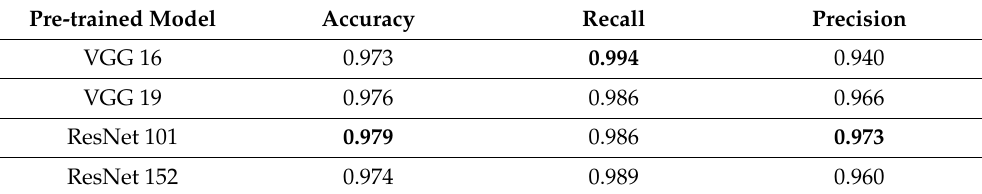
Table 5. Performance using decision tree.